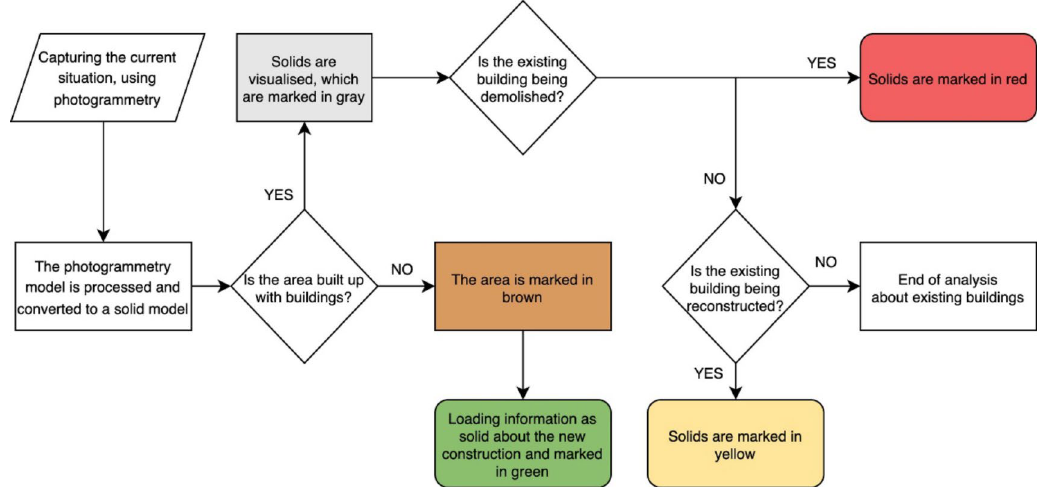
Figure 2. The algorithm to identify the current situation on the construction site